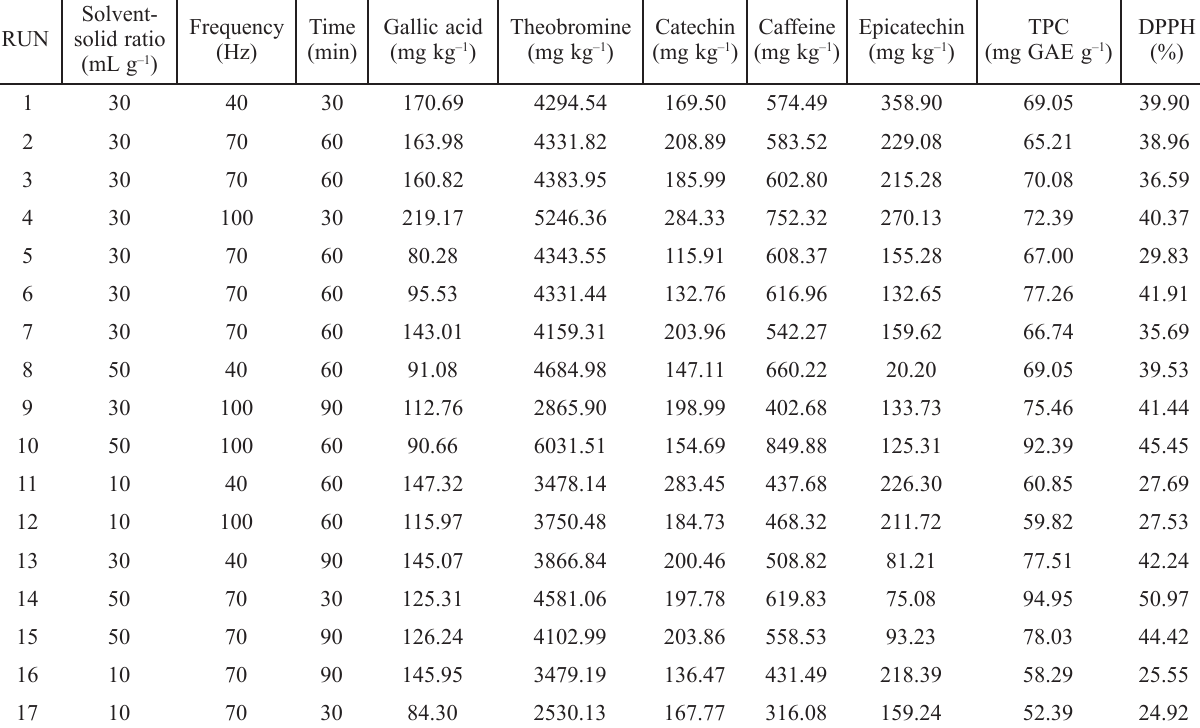
Table 3 – Bioactive components detected in CBS extracts obtained by HVED Solvent- RUN solid